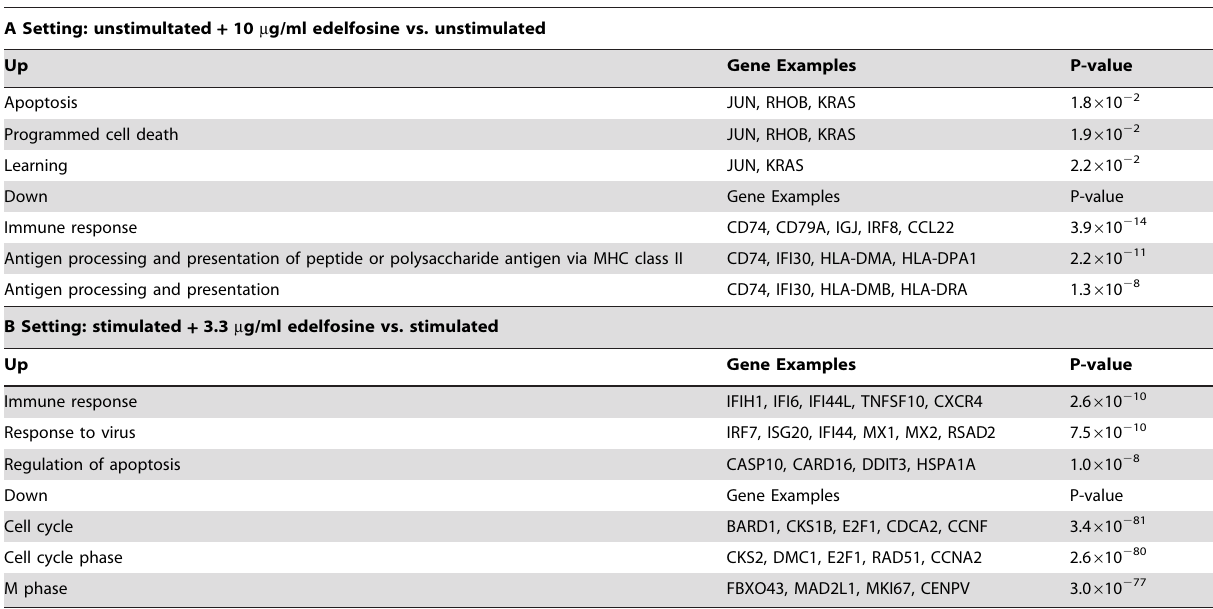
Table 2. Clustering of up- or downregulated genes to determine biological pathways affected by edelfosine in human CD4 + T cells after gene expression